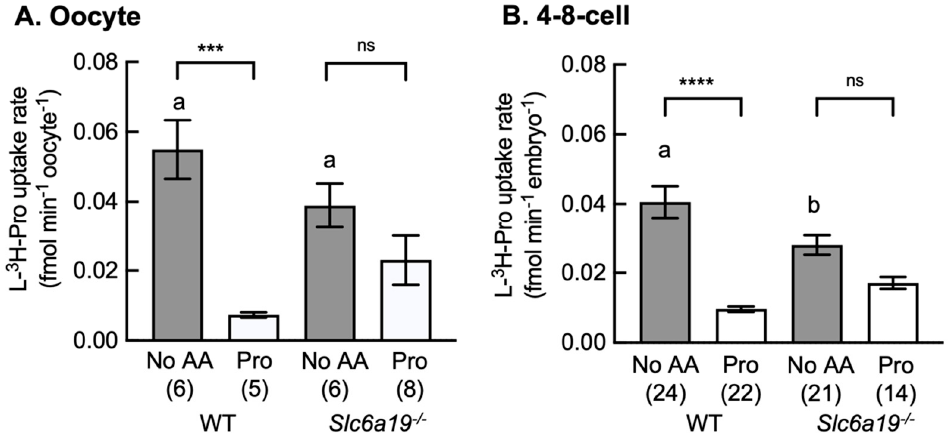
Figure 4. Excess unlabelled Pro reduces the rate of L-[ 3 H]-Pro uptake in WT but not Slc6a19 − / − embryos. Rate of uptake of 1 µ M L-[ 3 H]-Pro in ( A ) oocytes, and ( B ) 4–8-cell embryos from wild-type (WT) and Slc6a19 − / − mice without (No AA) or with molar excess of unlabelled Pro (0.4 mM). Each bar represents the mean ± SEM with the number of replicates given in parentheses. Each replicate was performed on 1–4 oocytes or embryos over at least 3 independent experiments. Data were analysed by Student’s t -test. ‘No AA’ bars with different letters (a,b) are significantly different ( p < 0.05). *** and **** indicate p < 0.001 and p < 0.0001 respectively; ns, not significant ( p > 0.05) for No AA vs Pro.